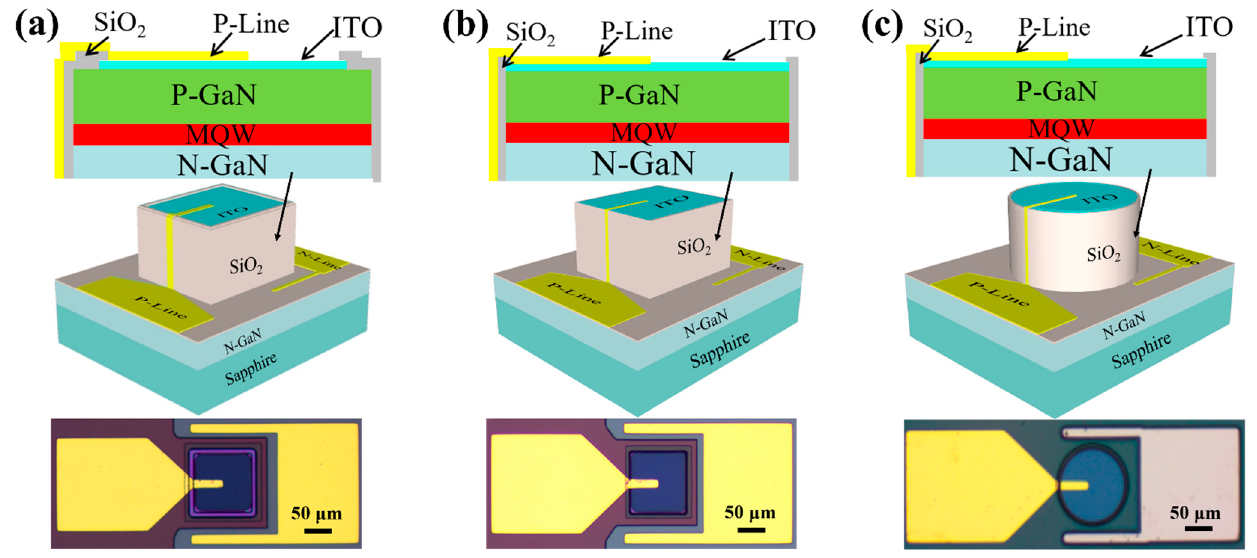
Figure 1. Micro LED ( a ) with ITO smaller than light emitting area ( b ) with ITO equal to light emitting area ( c ) with circular mesa ( ITO equal to light emitting area).